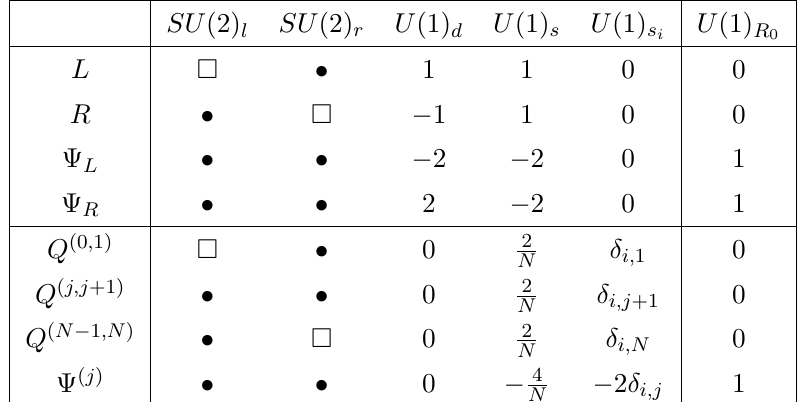
under the global